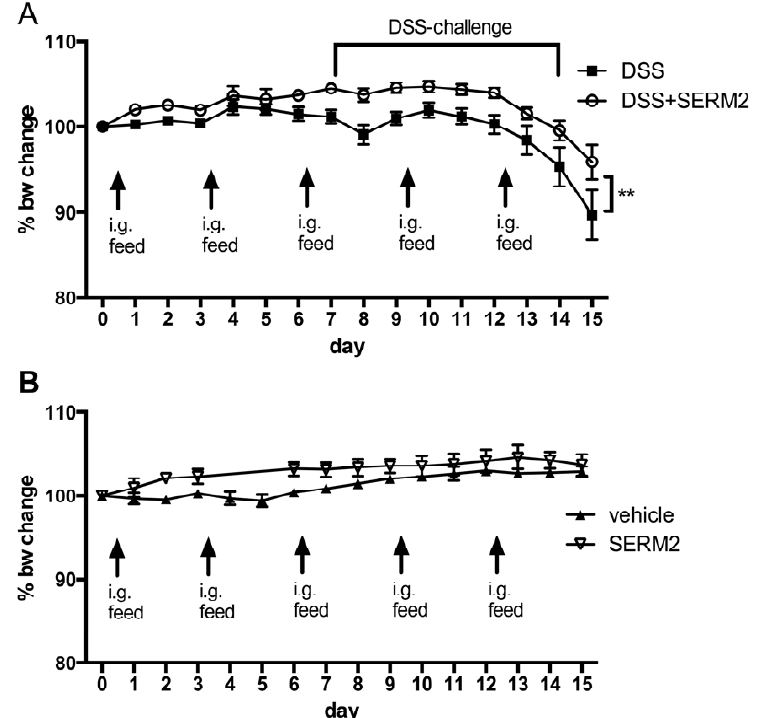
Figure 1. E ff ect of intragastrial SERM2 feeding (10 mg / kg bw 1 / 3 days) on mouse body weight ( A ) before and during the dextran sodium sulfate (DSS) challenge and ( B ) on healthy control mice. The data are pooled from two independent experiments and expressed as the mean ± SEM. n = 9 per DSS-challenged group and n = 5 for control groups. Statistical significance was calculated with two-way ANOVA and Bonferroni post hoc test. ** p <